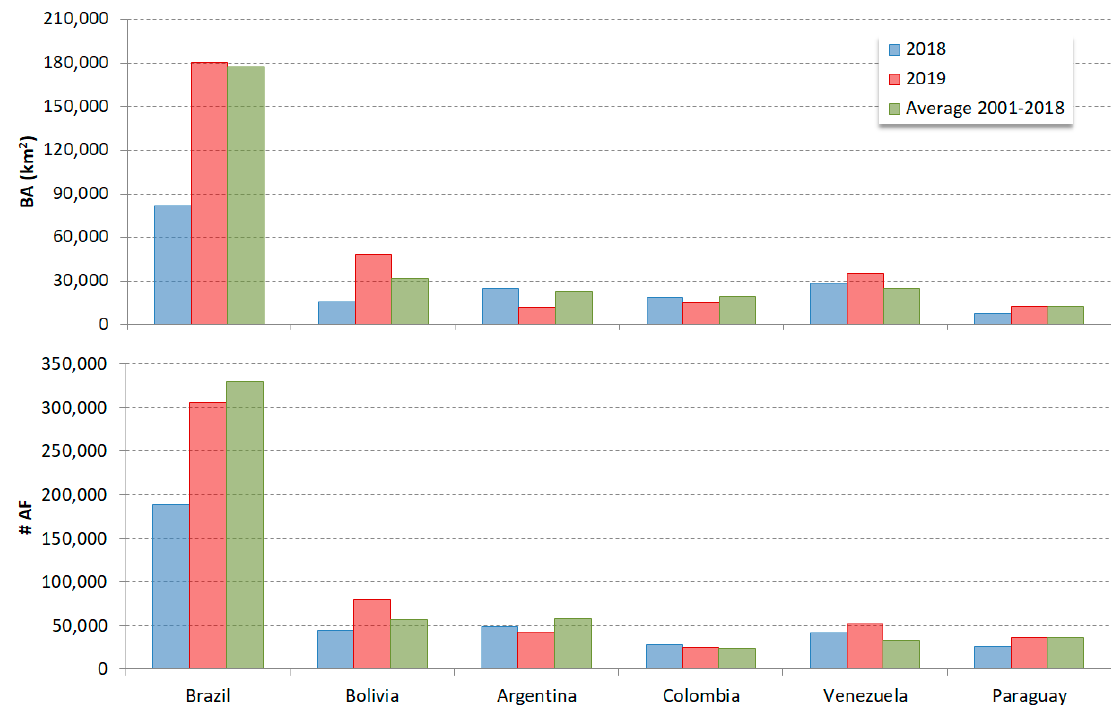
Figure 1. Country distribution of burned areas (BAs) and number of active fires (AFs) for 2018, 2019 and the average of the 2001–2018 period.